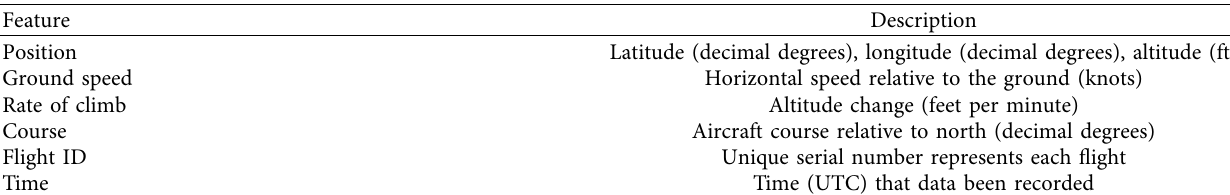
Table 2: 4D trajectory data